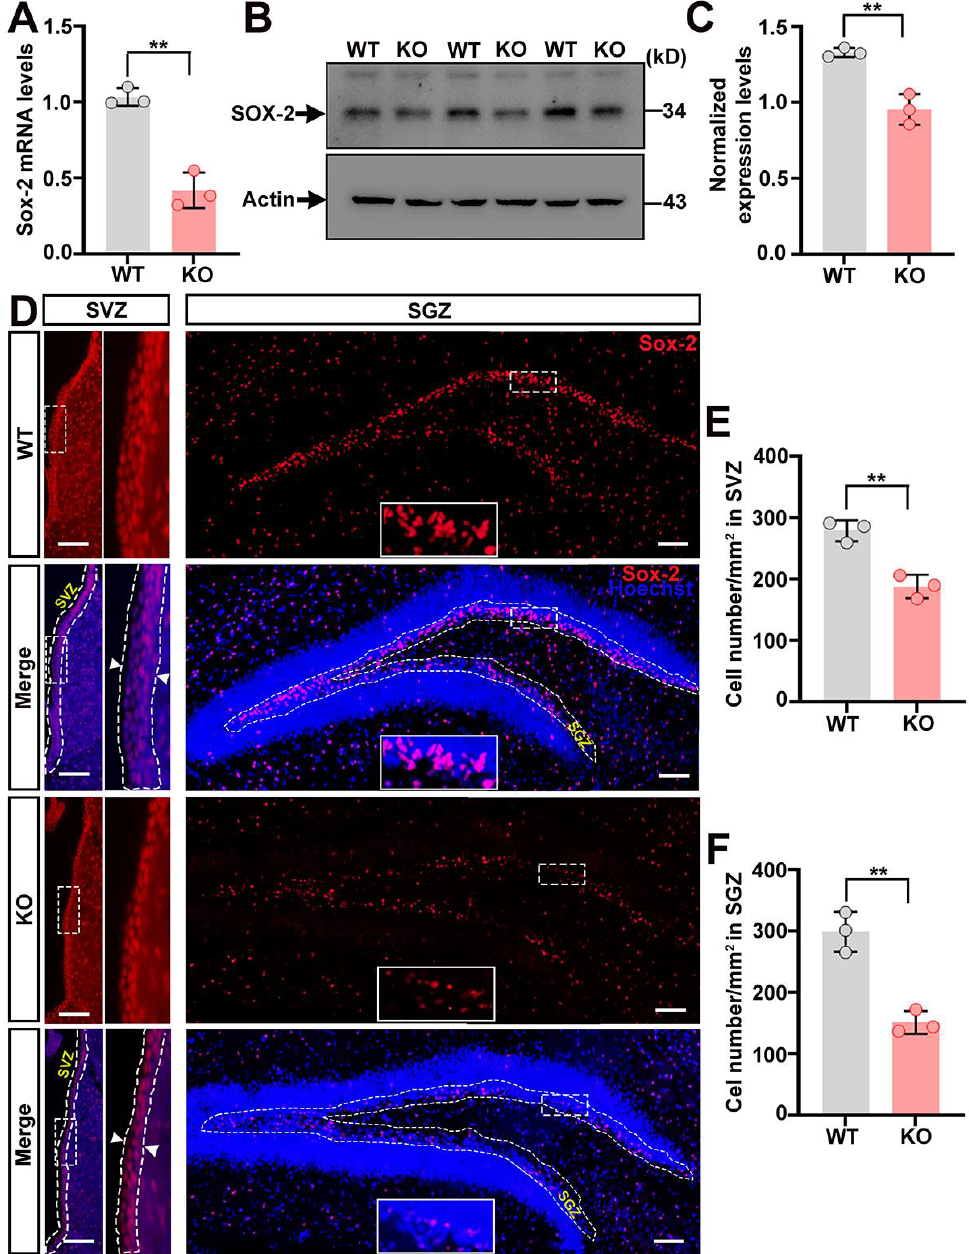
Figure 6. The content of neural stem cells declines in the brain of trappc9-deficient mice. Quantita- tive PCR ( A ) as well as Western blot ( B ) followed densitometry ( C ) analyses showed lower expres- sion levels of Sox-2 in the brain of 3-week-old trappc9-null (KO) mice as compared to age-matched